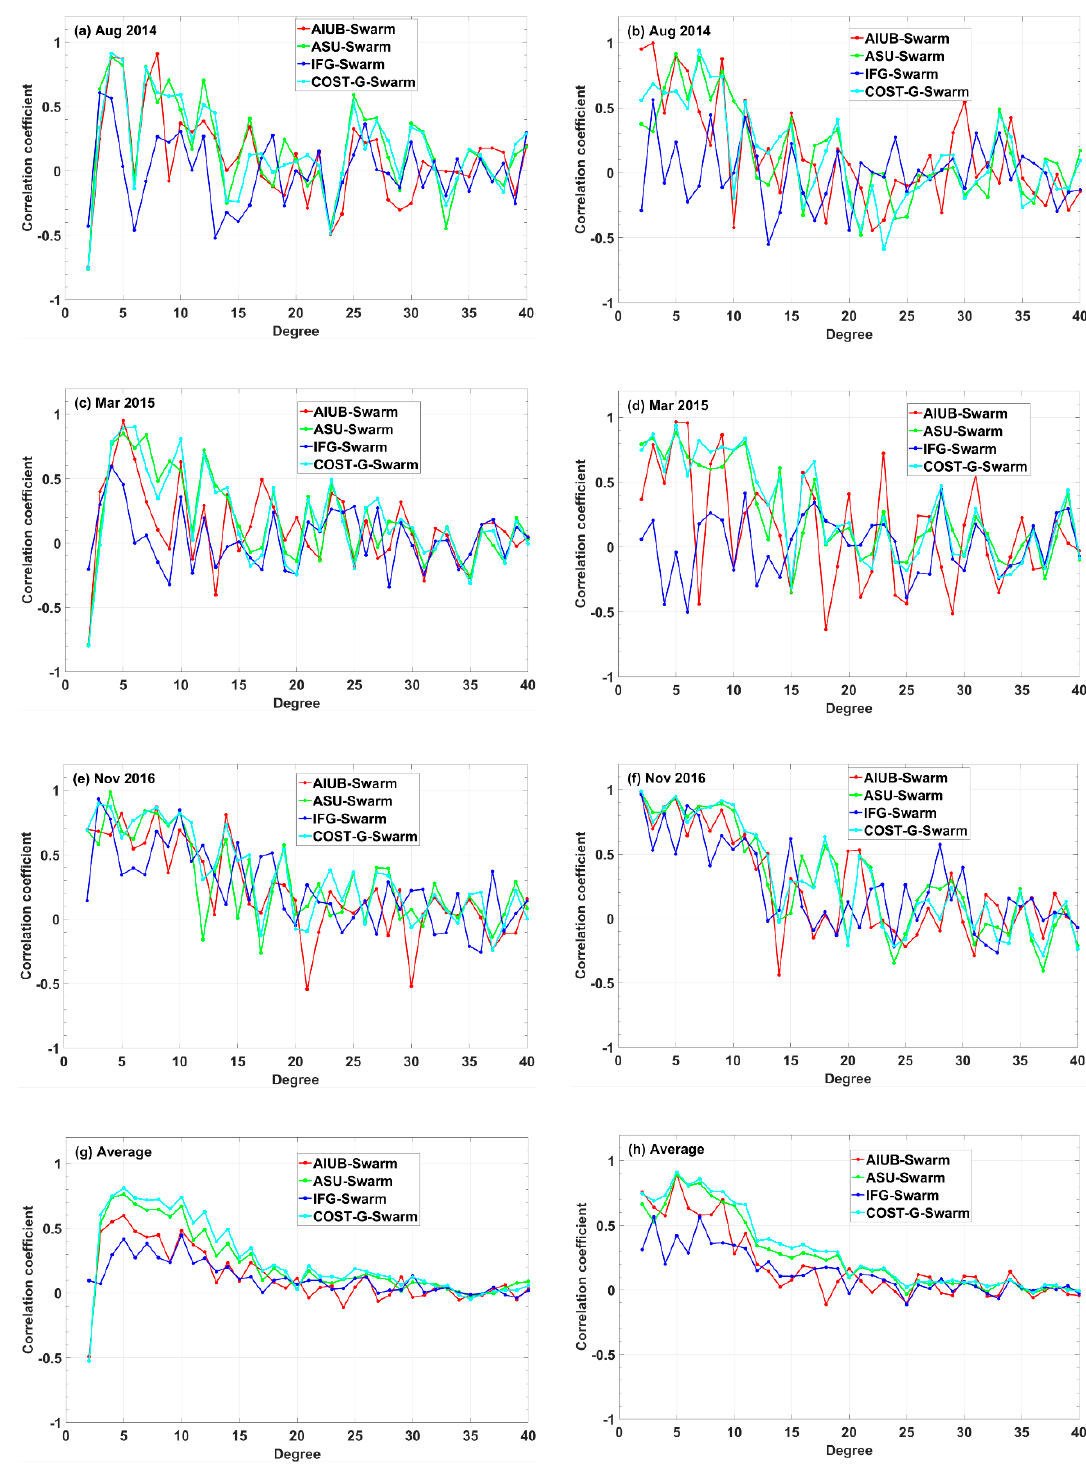
Figure 5. Degree correlation between Swarm and the GRACE models (left column is C coefficient results and right column is S coefficient results).